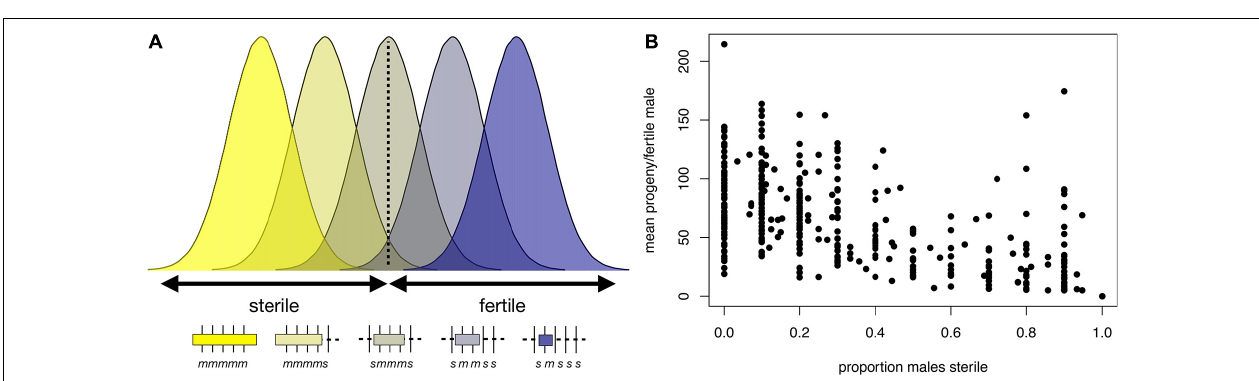
FIGURE 4 | Polygenic threshold model of HMS (adapted from Lienard et al., 2016). (A) The plot shows the distribution of a hypothetical quantitative trait, fertility potential, for five hypothetical introgression genotypes shown beneath the x -axis. For each genotype, the length of a D. mauritiana introgression is represented by the length of the open bar; the genotypes at five markers (vertical tick marks) are indicated by m and s , for D. mauritiana and D. simulans , respectively; and the average fertility of males is indicated by the color of the bar. The largest introgression ( mmmmm ) is completely male-sterile, whereas the smallest introgression ( smsss ) is completely fertile. For intermediate introgression genotypes, some proportion of males produce no progeny (those falling below the threshold) whereas others produce > 0 progeny. This polygenic threshold model suggests a correlation between the proportion of sterile males associated with a particular introgression genotype and the mean number of progeny produced by their fertile brothers. (B) Experimental data on D. mauritiana X-chromosome introgressions in a D. simulans genetic background show the predicted correlation (Spearman’s ρ = − 0.91, P < 0.0001) between the proportion of sterile males and the mean number of progeny among fertile males (for data and details see Meiklejohn et al.,